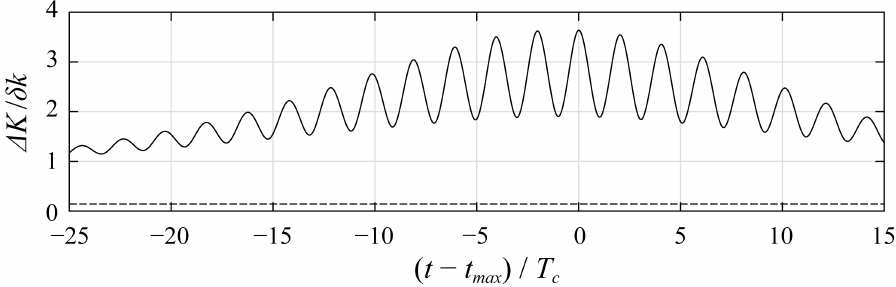
Figure 6. Temporal evolution of the mean wavenumber difference ∆ K / δ k of the modulated wave train with a 0 k c = 0.105 at approximately the time of the maximum crest height ( t = t max ) in the HOSM simulation. The dashed line represents the initial